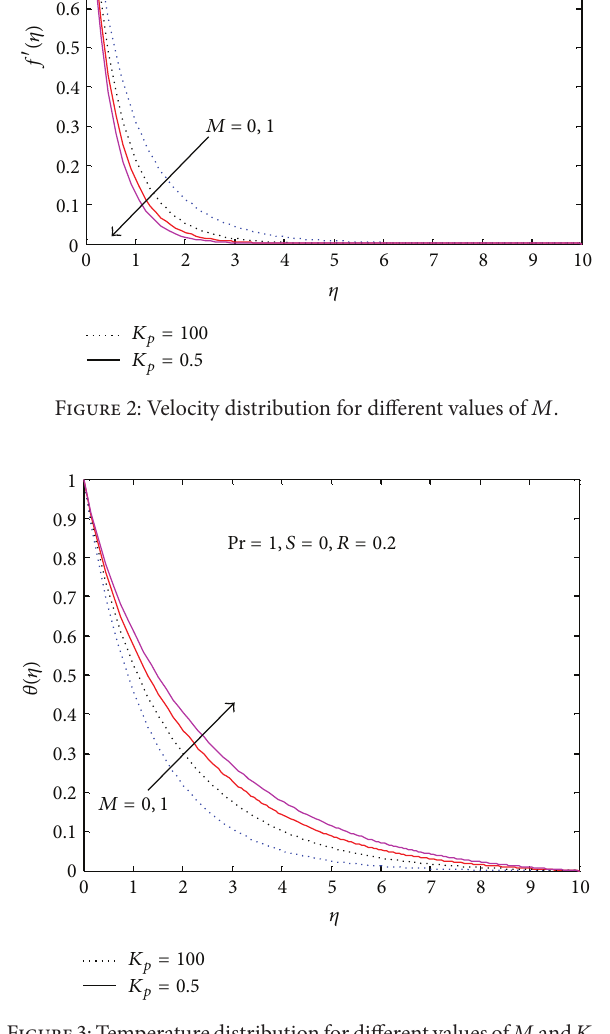
Figure3:Temperaturedistributionfordifferentvaluesof 𝑀 and 𝐾 𝑝